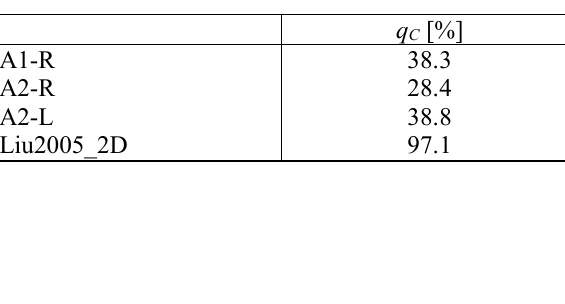
Table 2. Relative amount of pollutant q C inside all